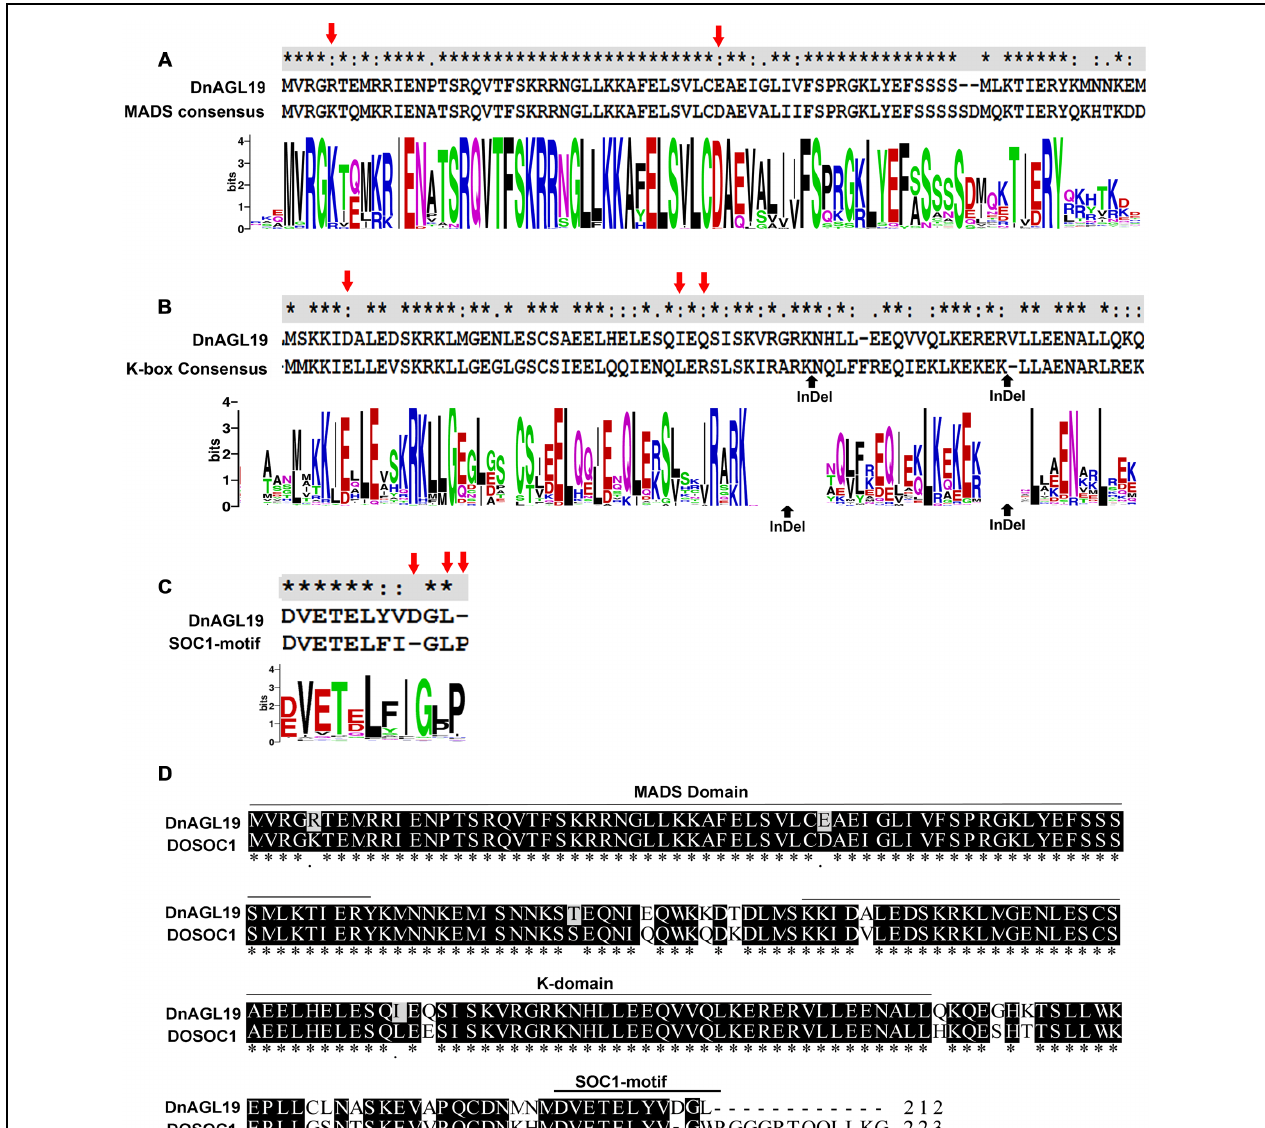
FIGURE 2 | Alignment of DnAGL19 to DOSOC1 and consensus sequences of the conserved domains. Consensus sequences of the MADS-box (A) , K-domain (B) and SOC1-motif (C) of SOC1/TM3-like proteins were generated by WebLoGo based on an alignment of DnAGL19, DOSOC1 and 151 SOC1-motif-containing proteins. The consensus sequences are shown above the graphs to align to corresponding domains on DnAGL19. “ ∗ ” indicates the conserved sites. In panel (B) , two indel sites are indicated by upward pointing arrows. Panel (D) shows the alignment of DnAGL19 to DOSOC1. Identical sites are shaded. The variations within the MADS Box, the K domain and the SOC1-motif are indicated by red downward pointing arrows in panel (A–C)